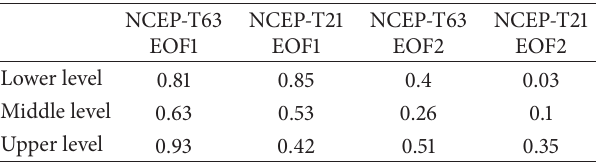
Table 3: Spatial correlation coefficients of dominant variability patterns (EOF1 and EOF2) between the reanalysis data and the control runs of the quasi-geostrophic model with T63 and T21 for the atmospheric